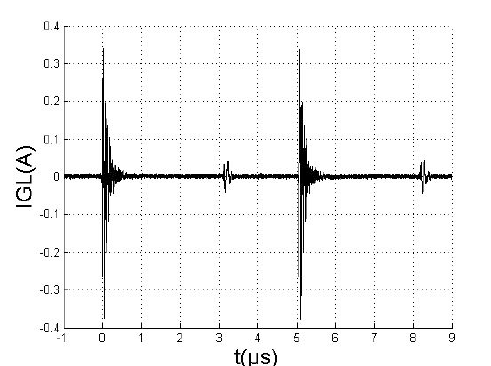
Figure 20: Experimental waveform of the current i